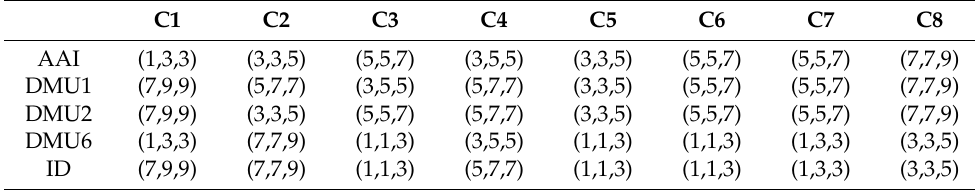
Table 10. Extended fuzzy initial decision matrix.